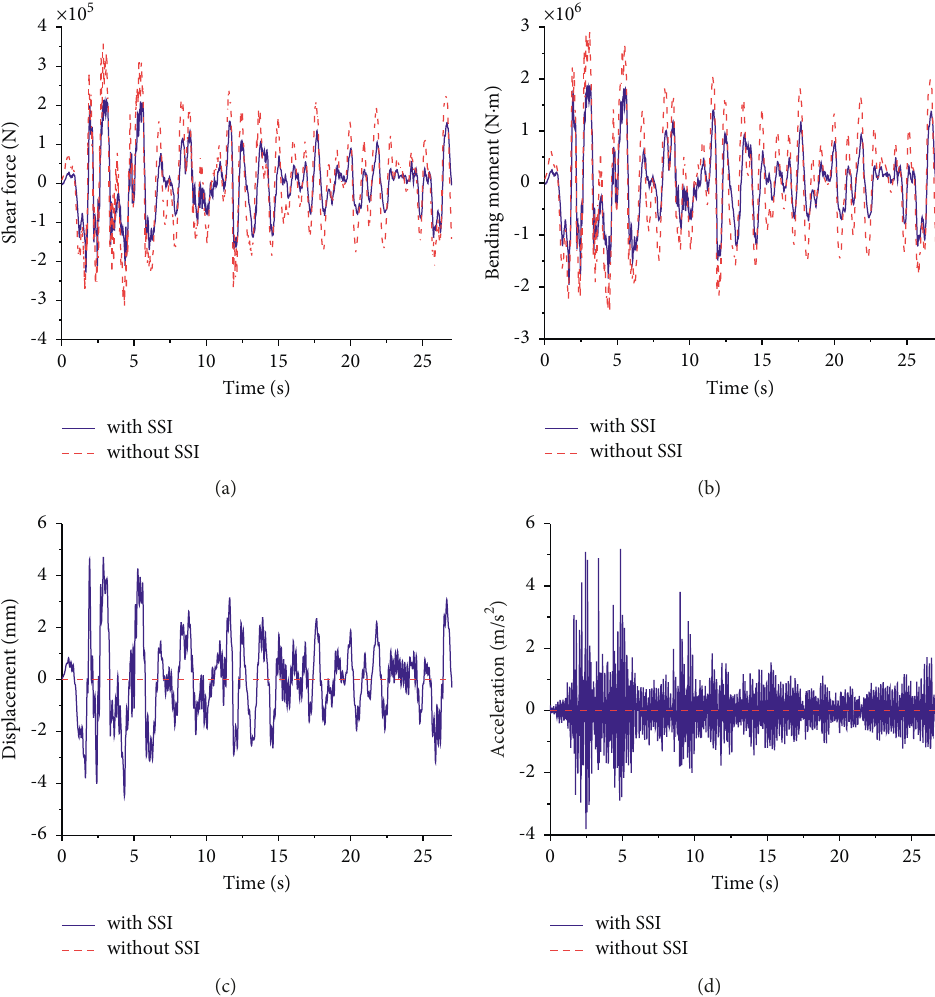
Figure 9: Comparison of the dynamic responses of the pier bottom under ElCentro wave. (a) Shear force at the pier bottom. (b) Bending moment at the pier bottom. (c) Displacement at the pier bottom. (d) Acceleration at the pier bottom.